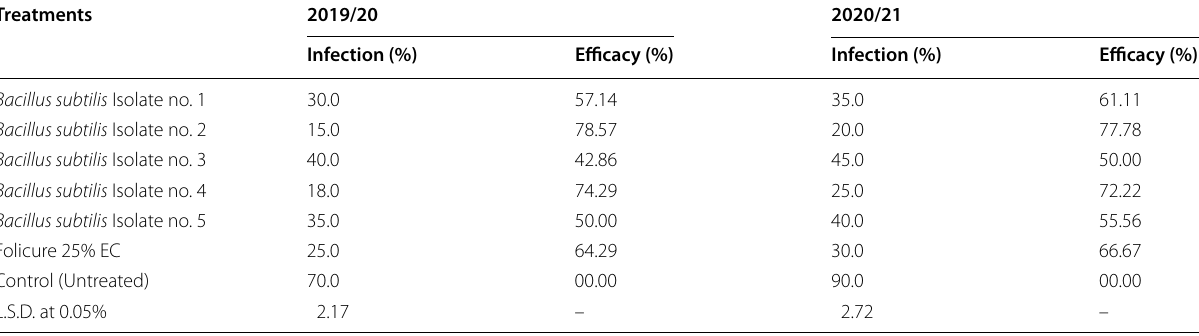
Table 2 Effect of Bacillus subtilis isolates and Folicure fungicide treatments on onion white rot disease incidence under greenhouse conditions during 2019/20 and 2020/21 growing seasons